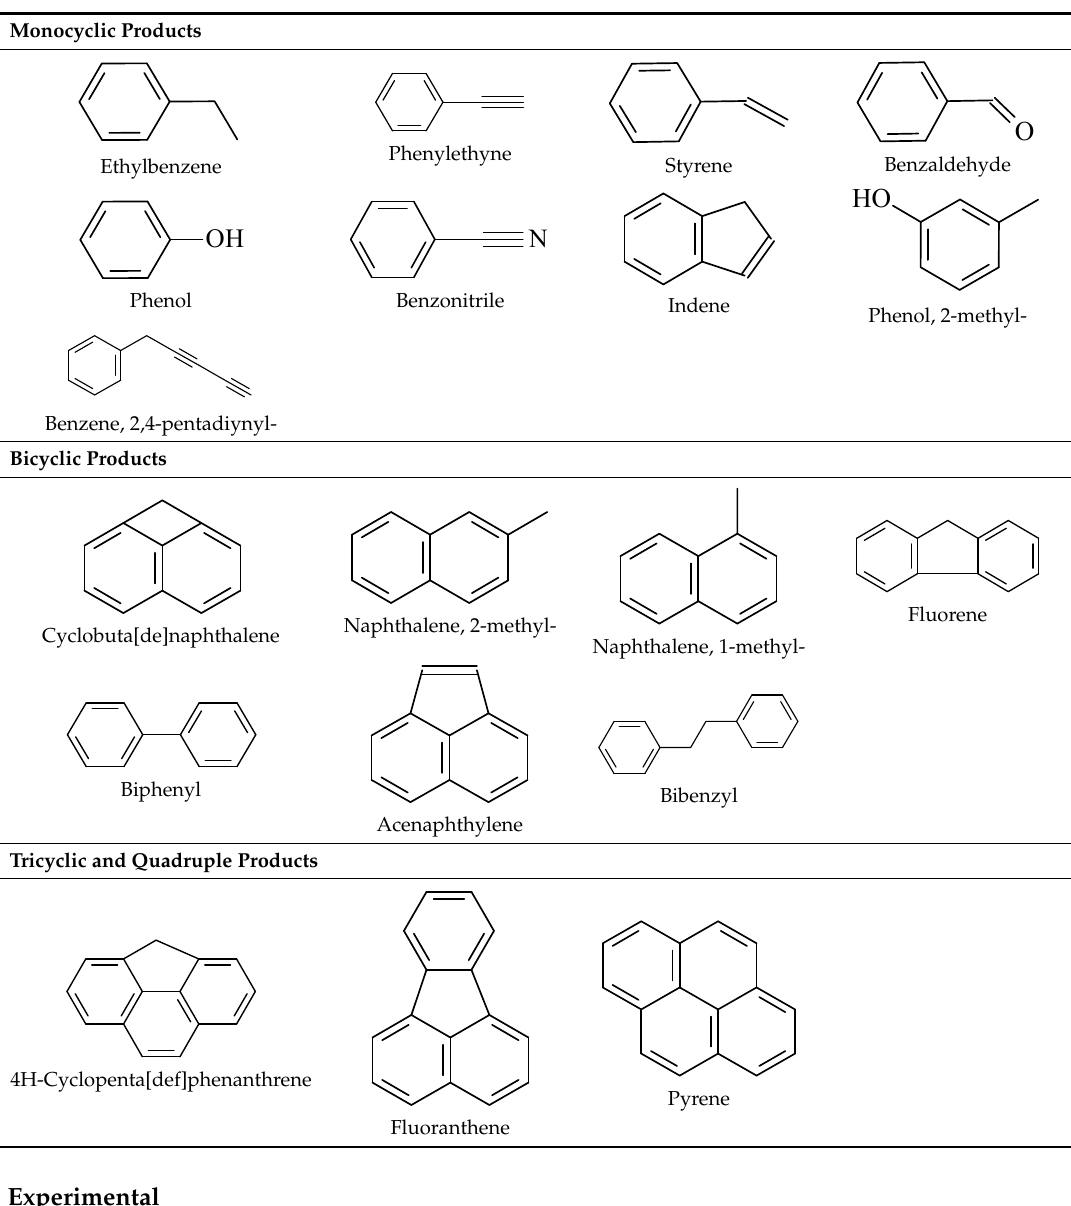
Table 2. Relevant liquid by-product structures.